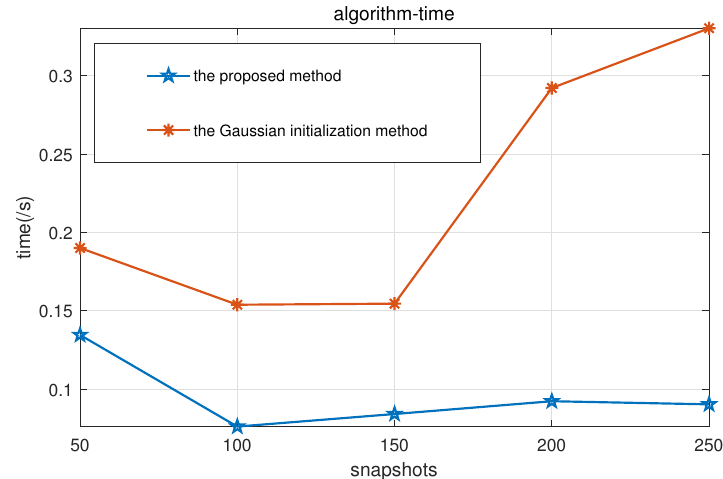
Figure 9. Average time required for each algorithm